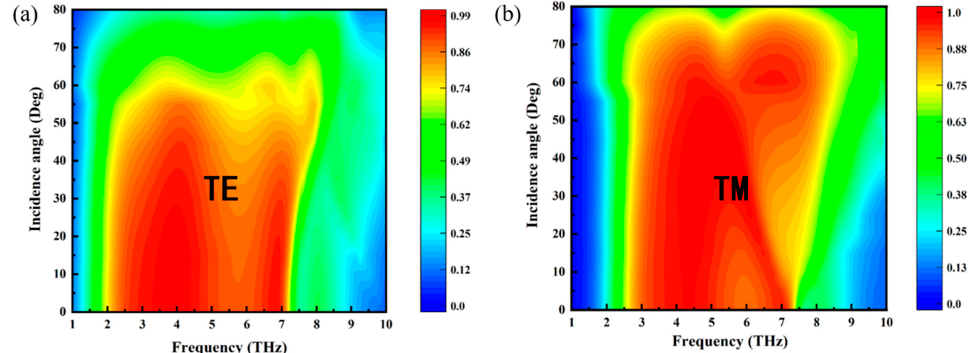
Figure 8. Absorption spectrum of different geometric parameters such as ( a ) the length of outer ring l 1 , ( b ) the length of middle ring l 2 , ( c ) the length of inter block l 3 , ( d ) the width of rings w , ( e ) the gap width t on the rings, and ( f ) four different structures.